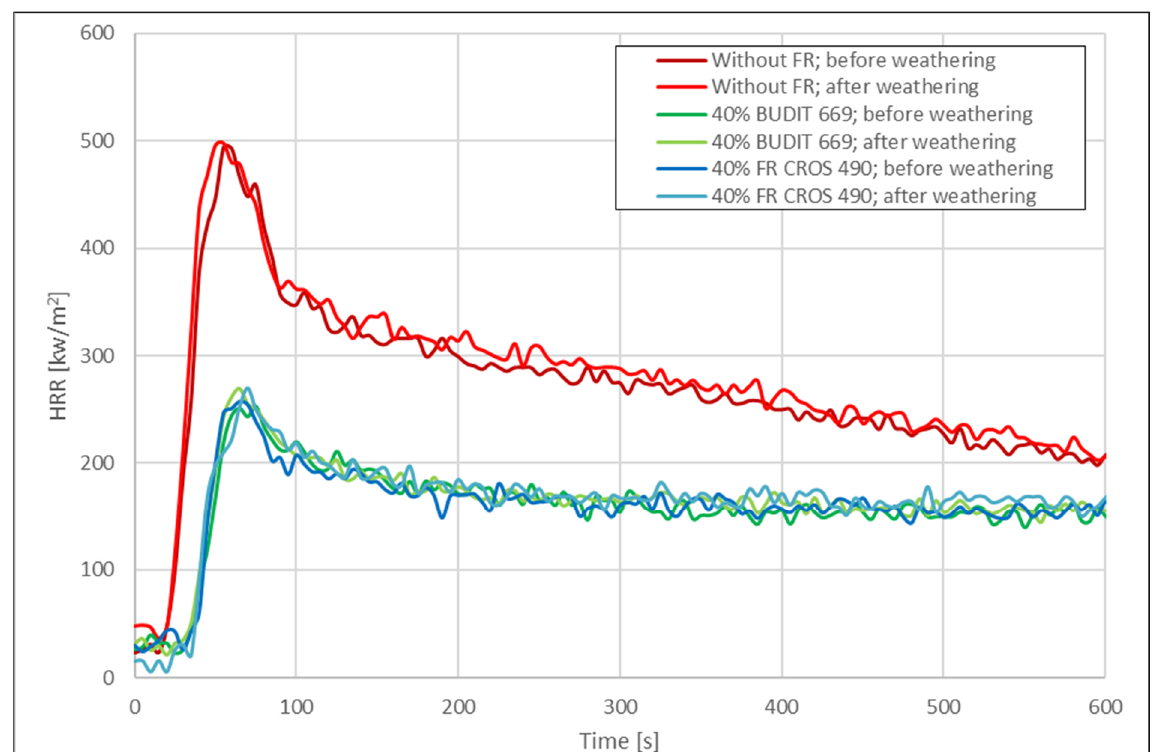
Figure 6. HRR of co-extruded solid profiles before and after artificial weathering according to DIN EN ISO 4892-2 (cycle 2).